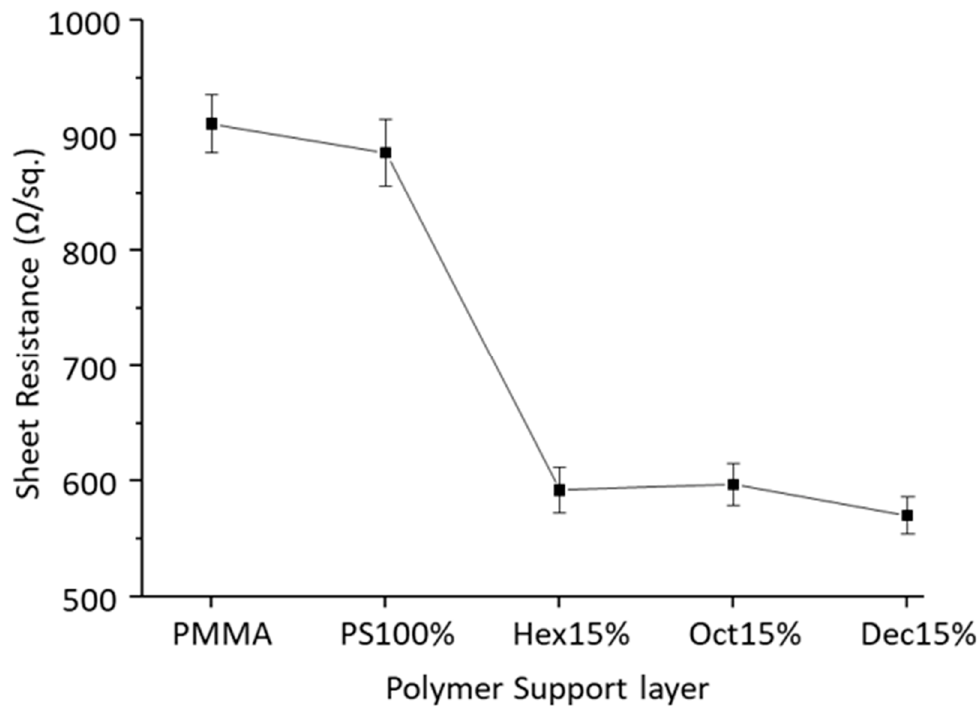
Figure 6. Average Sheet resistance measurement of transferred graphene.